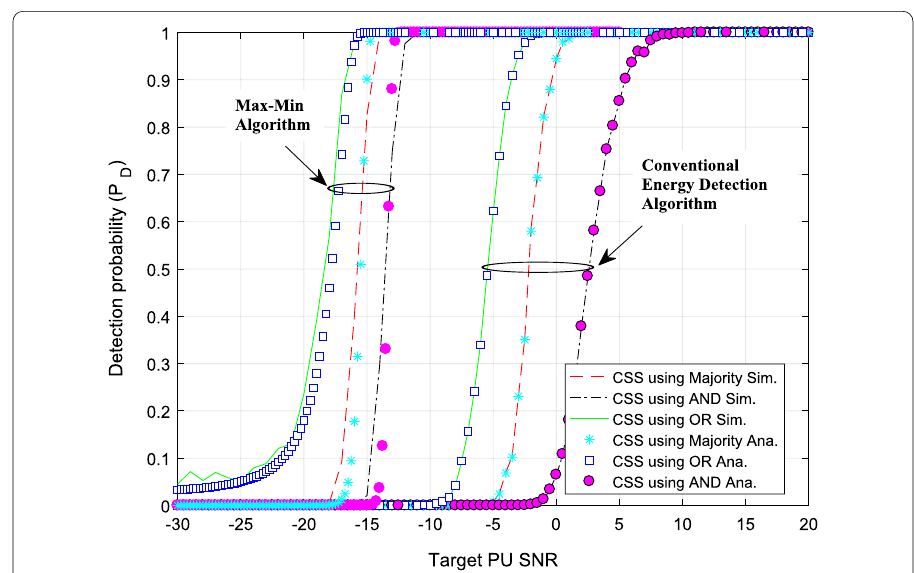
Fig. 10 Comparison of CSS detection probabilities between traditional ED and Max–Min ED with three different linear fusion rules for 2x-oversampled QPSK PU signal under Indoor channel and log-normal fading ( σ = 9dB ), the length of FFT N FFT = 8 , the number of sensing stations M N 20,480, and 1 dB =